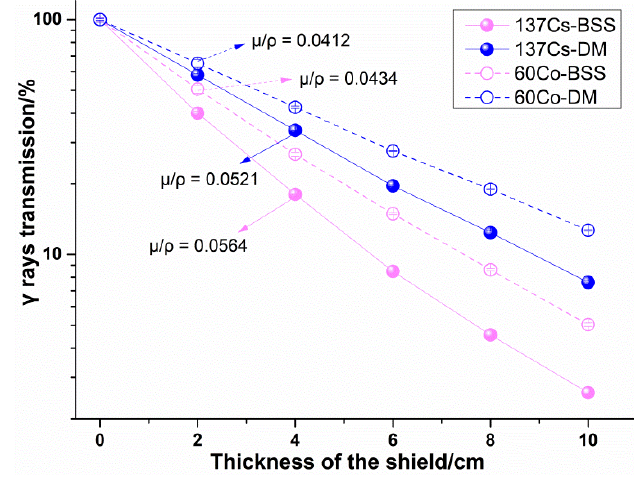
Figure 9. γ rays transmission experiment results. Table 5. Linear attenuation coefficient and mass attenuation coefficient of the materials.